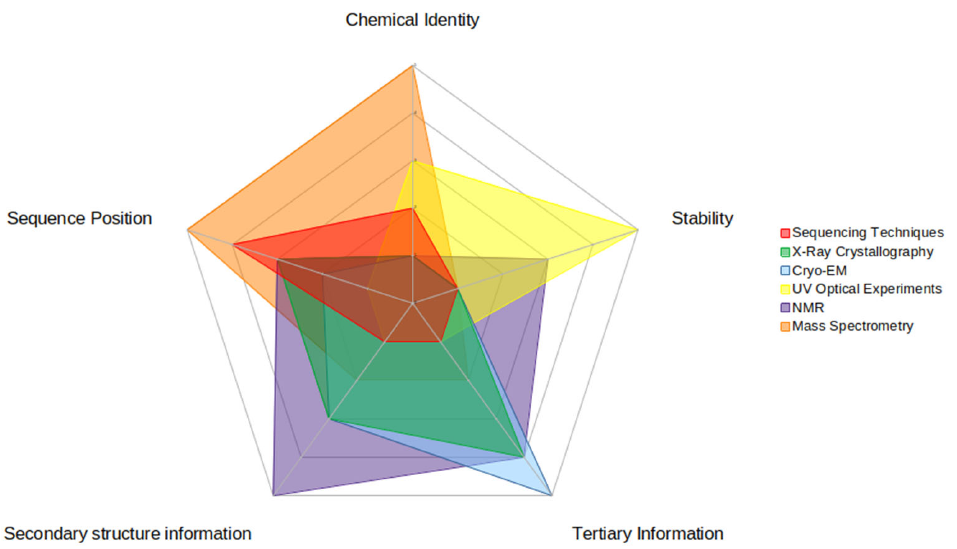
Figure 4. This figure illustrates the relative strengths and weaknesses of each experimental technique for each piece of data that is useful in computational investigations. There are five pieces of data highlighted here: (clockwise on the figure) chemical identity (of the RNA modification), stability (of the modified RNA structure), secondary structure information (of the modified RNA), tertiary information (of the modified RNA), and sequence position (of the RNA modification). Strengths are represented by higher numbers (towards the outside of the circle) while weaknesses are represented by lower numbers (inside of the circle). The relative strength score was based upon how much information the experimental technique could impart to each type.